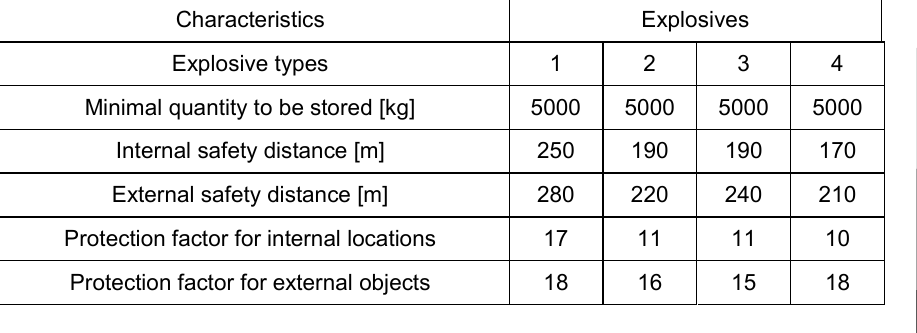
Table 3 – Characteristics of dangerous goods Таблица 3 – Характеристики опасных материалов Tabela 3 – Karakteristike opasnih